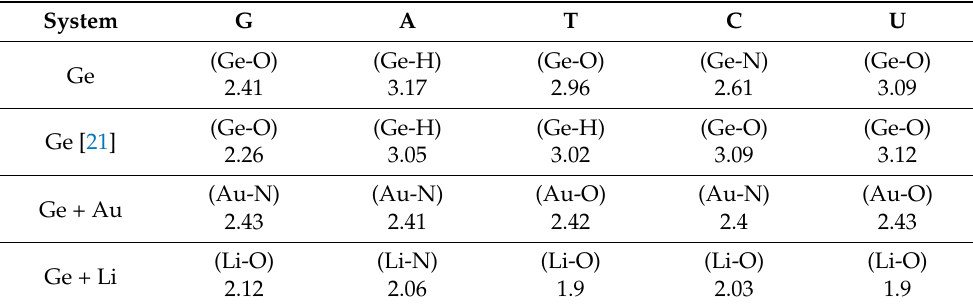
Table 3. The closest adsorption distances between the monolayer atom (Ge)/adatom (Li/Au) and the closest atom of the nucleobases. Values are in A 0